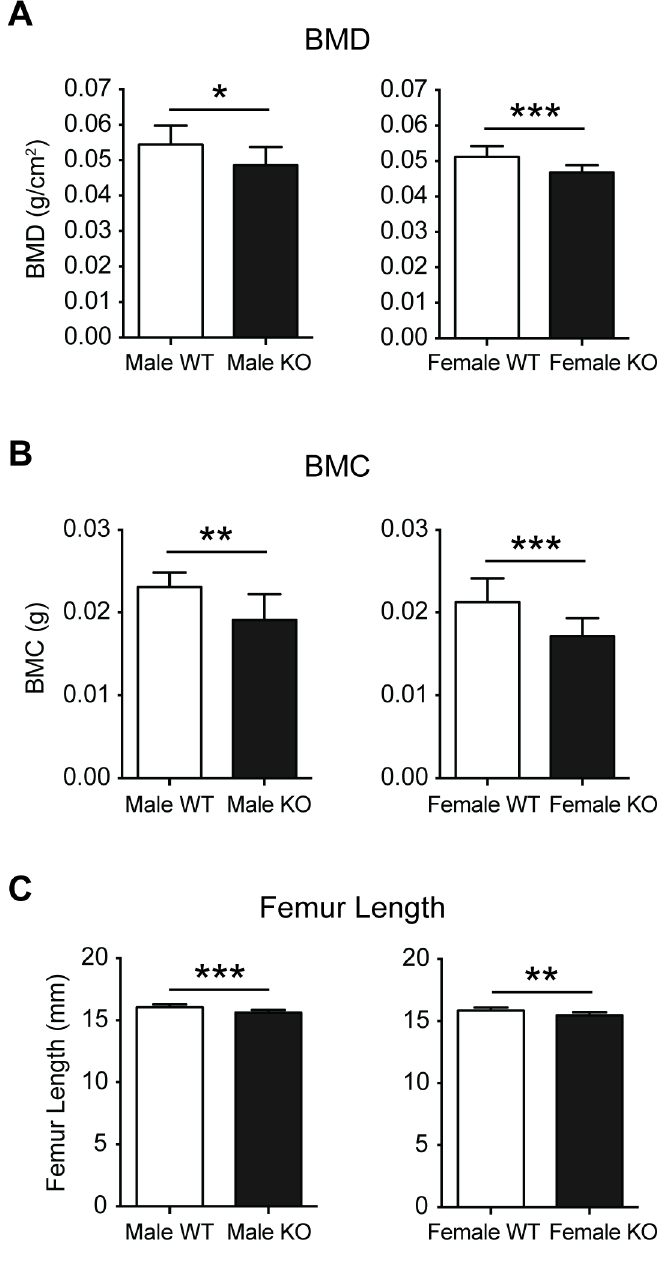
Fig 1. Whole bone analysis of PWCR KO mice. Femurs from 16 week old male and female PWCR KO and WT mice were dissected and analysed by DXA and measured for length. A.) BMD; B.) BMC and C.) femur length. n = 7 – 10 represented as mean ± SD. * p-value < 0.05, ** p-value < 0.01, *** p-value <